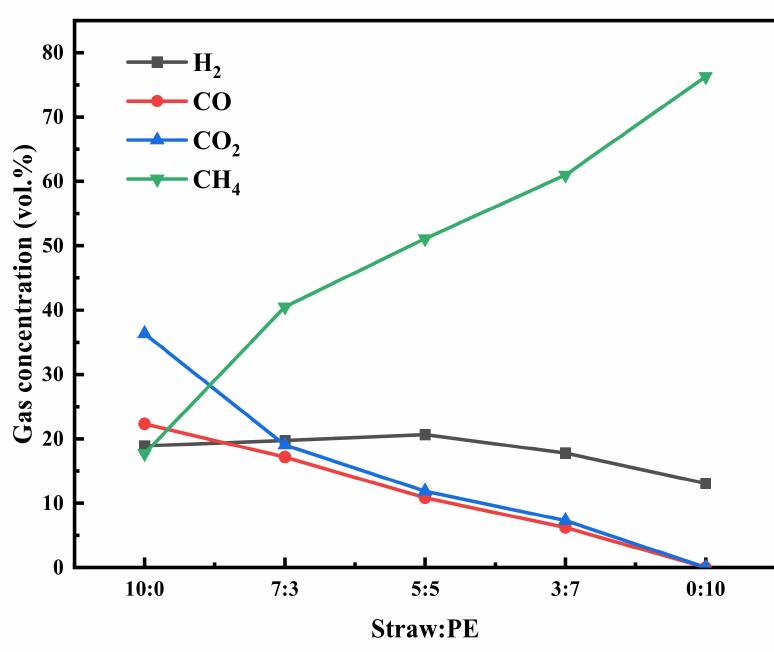
Figure 5. Pyrolysis gas components with different ratios of raw